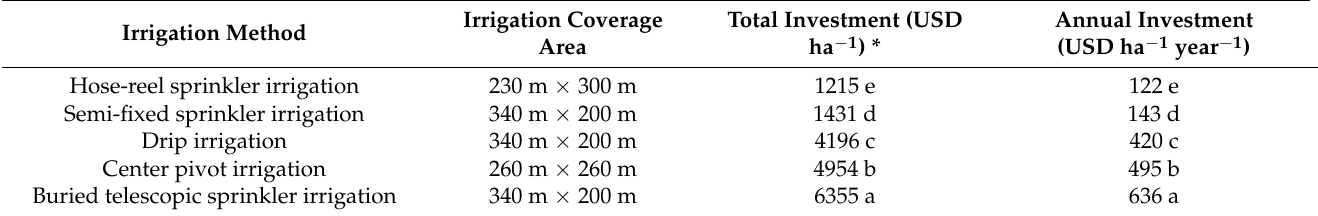
Table 2. Investment of irrigation equipment per ha for maize production in the North China